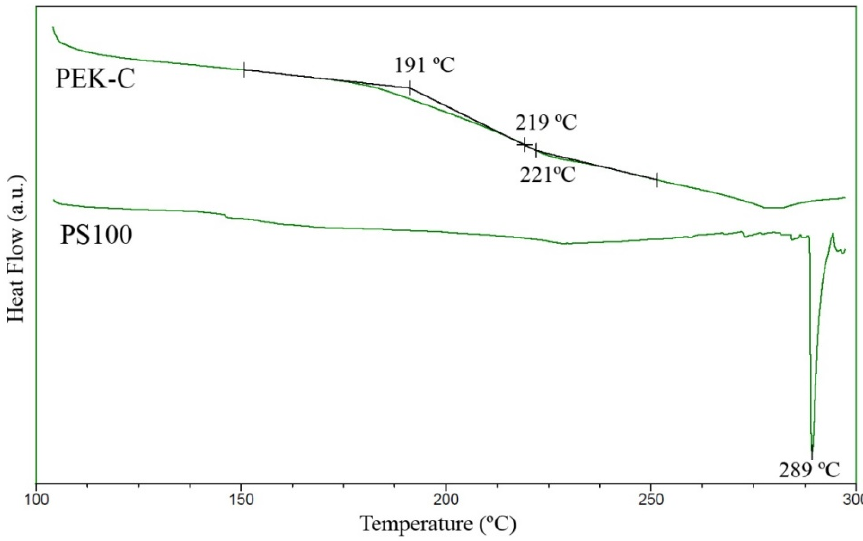
Figure 3. DSC curves of PEK-C and PS100 films.